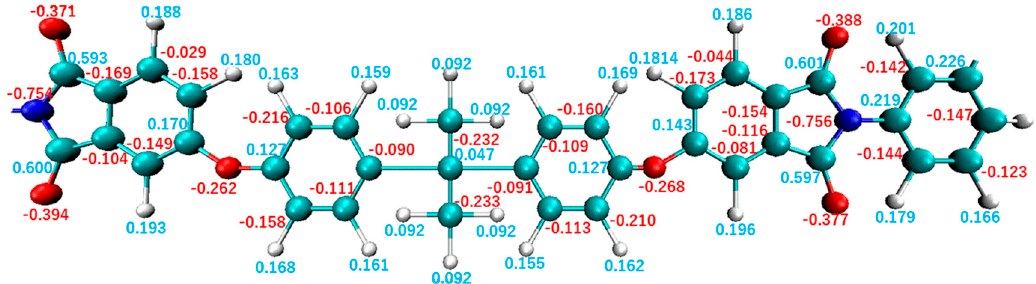
Figure 4. Charge distribution in a monomer of PEI.